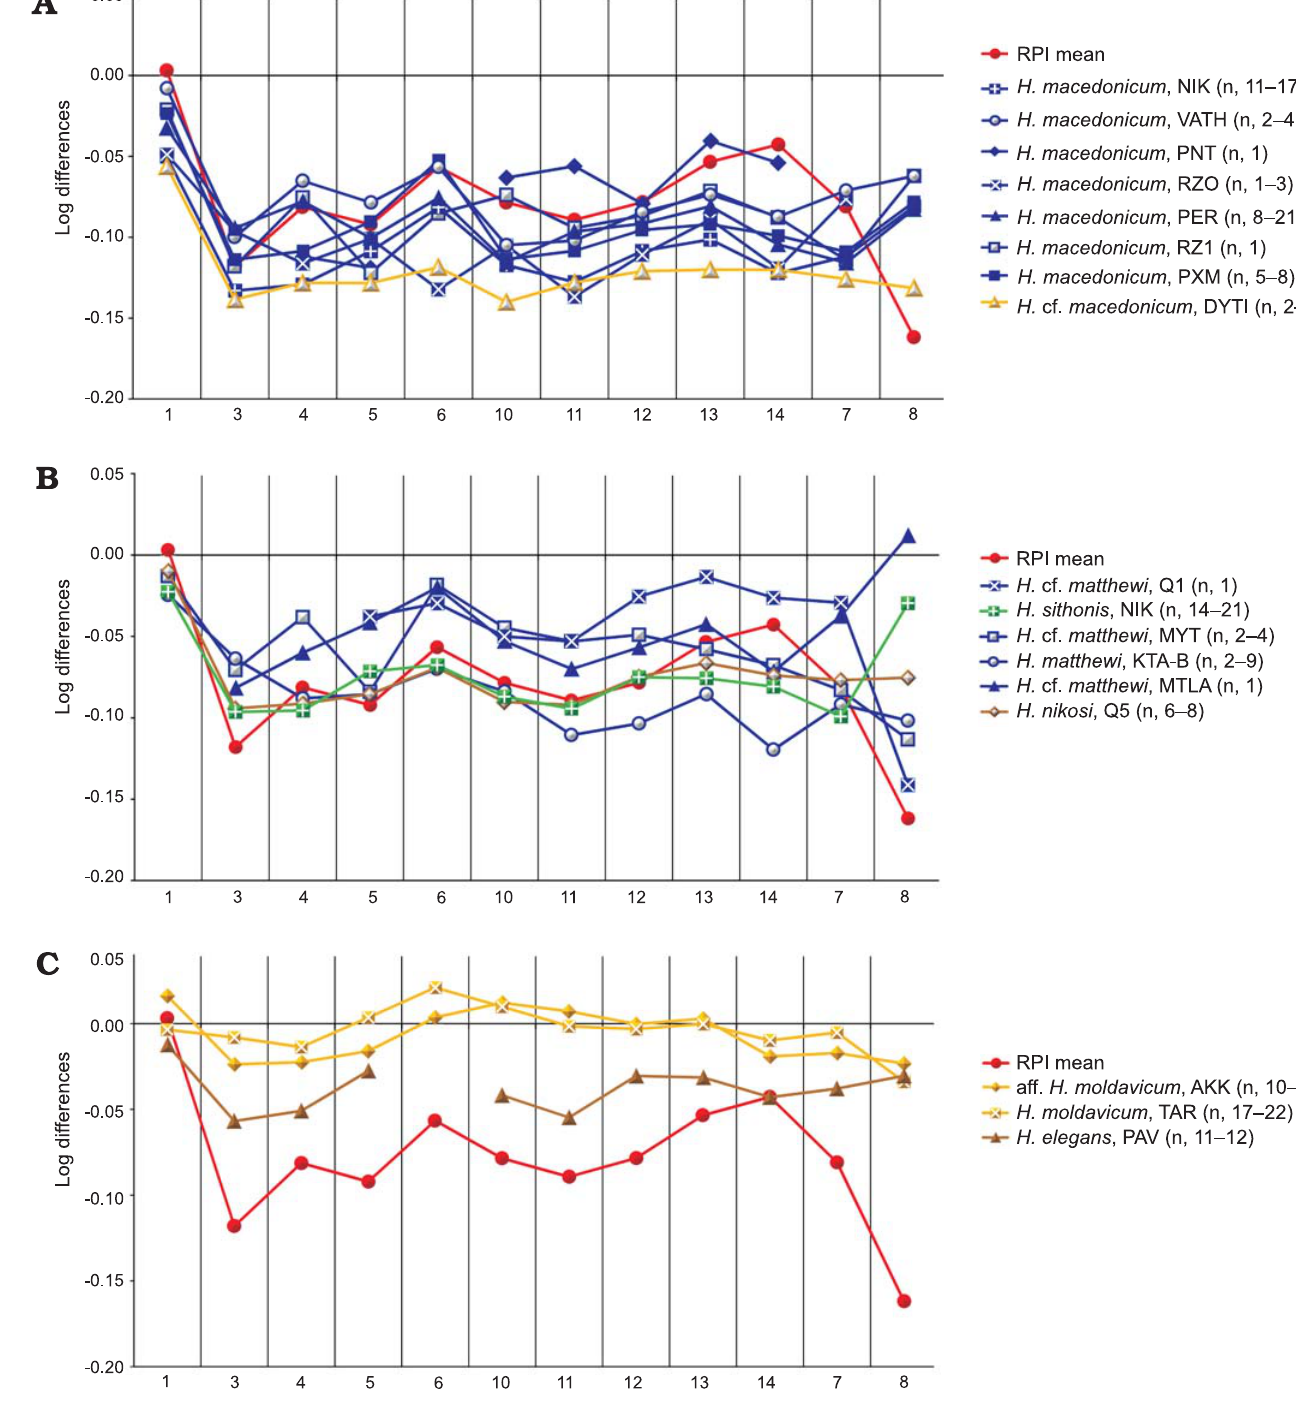
Fig. 7. Logarithmic ratio diagram comparing the RPl third metatarsal with Hipparion macedonicum and other small-sized hipparions from various lo- calities. Hipparion mediterraneum from Pikermi (Koufos 1987a) is used as standard of comparison. The metrical data for the hipparions from Greek localities and AKK are from my own archive; those for Hipparion moldavicum from TAR and Hipparion elegans from PAV are taken from http://www.